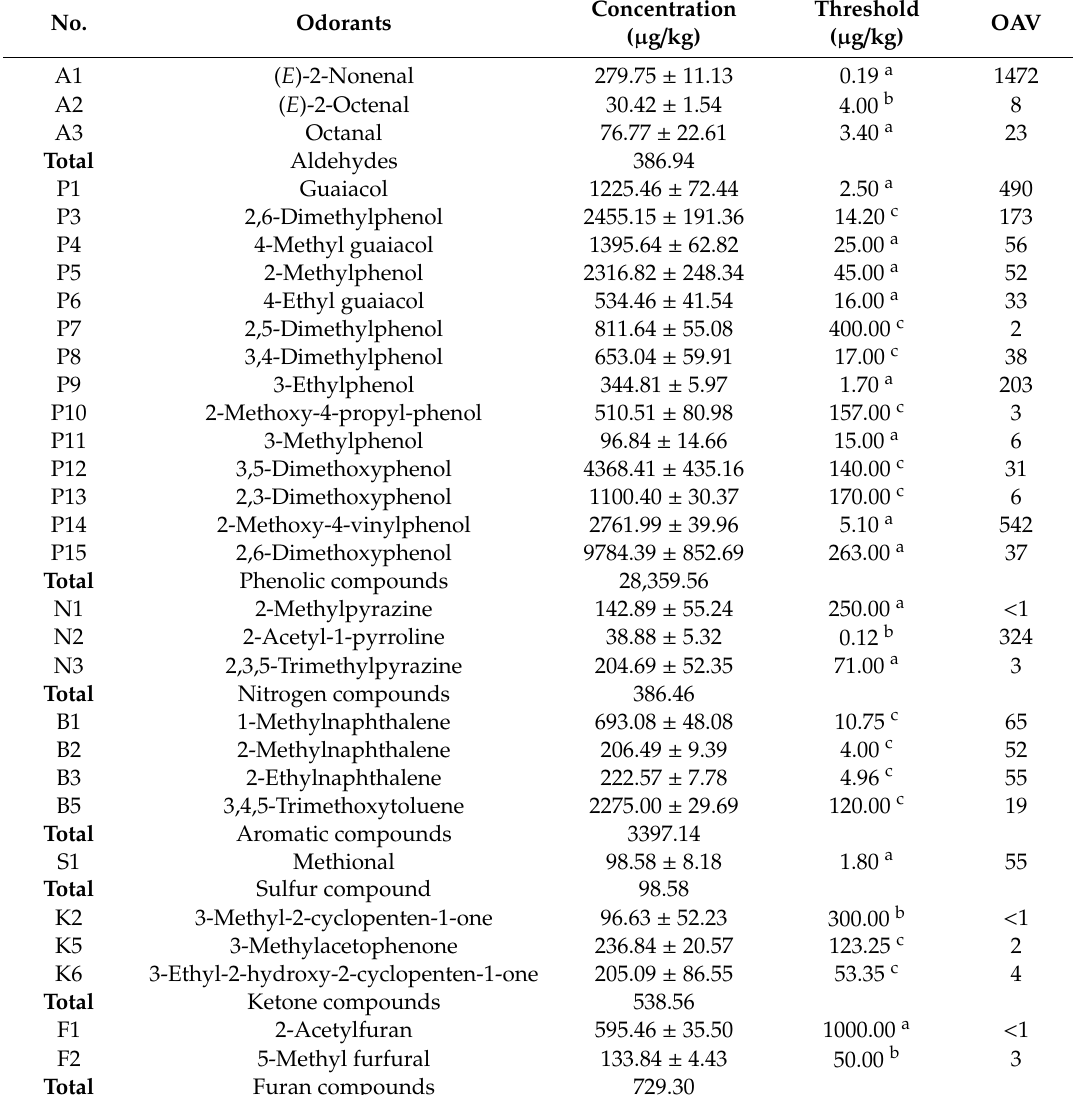
Table 3. Concentrations and odor activity values (OAVs) of the aroma-active compounds detected in traditional Hunan smoke-cured pork leg